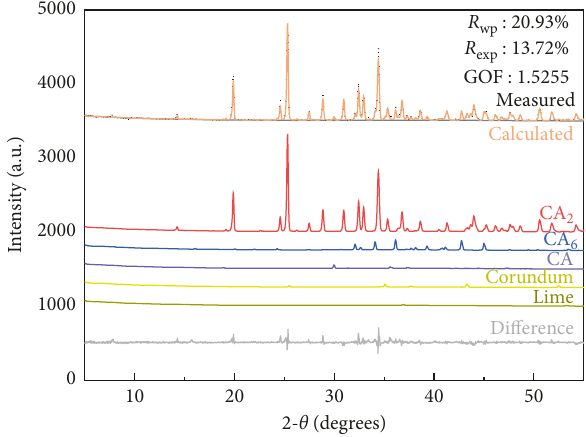
Figure 4: XRD pattern of synthesized CA